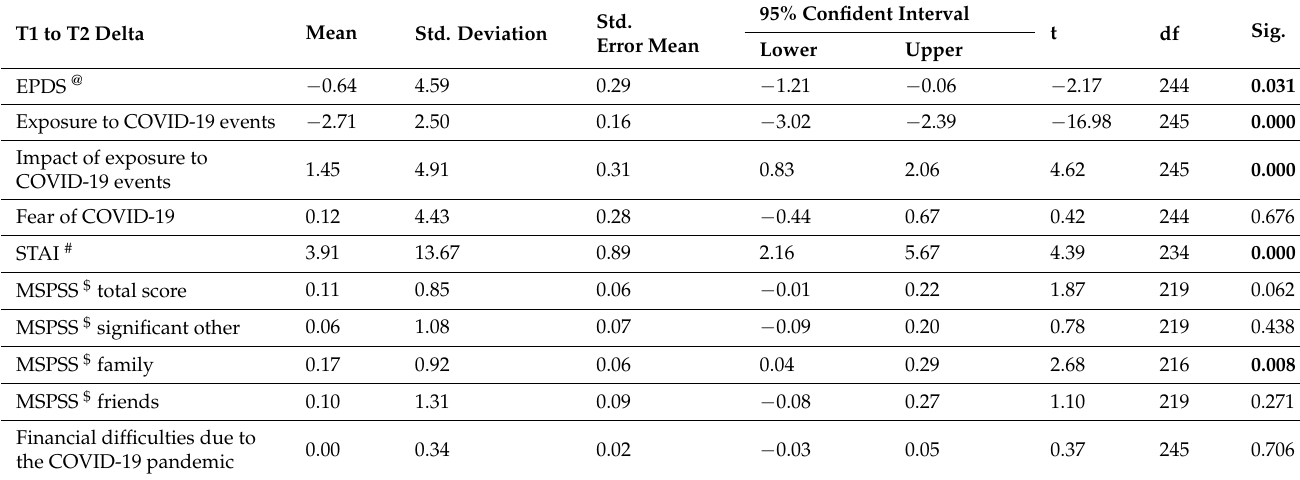
Table 2. Paired samples test: comparing the results of the T1 and T2 questionnaires.